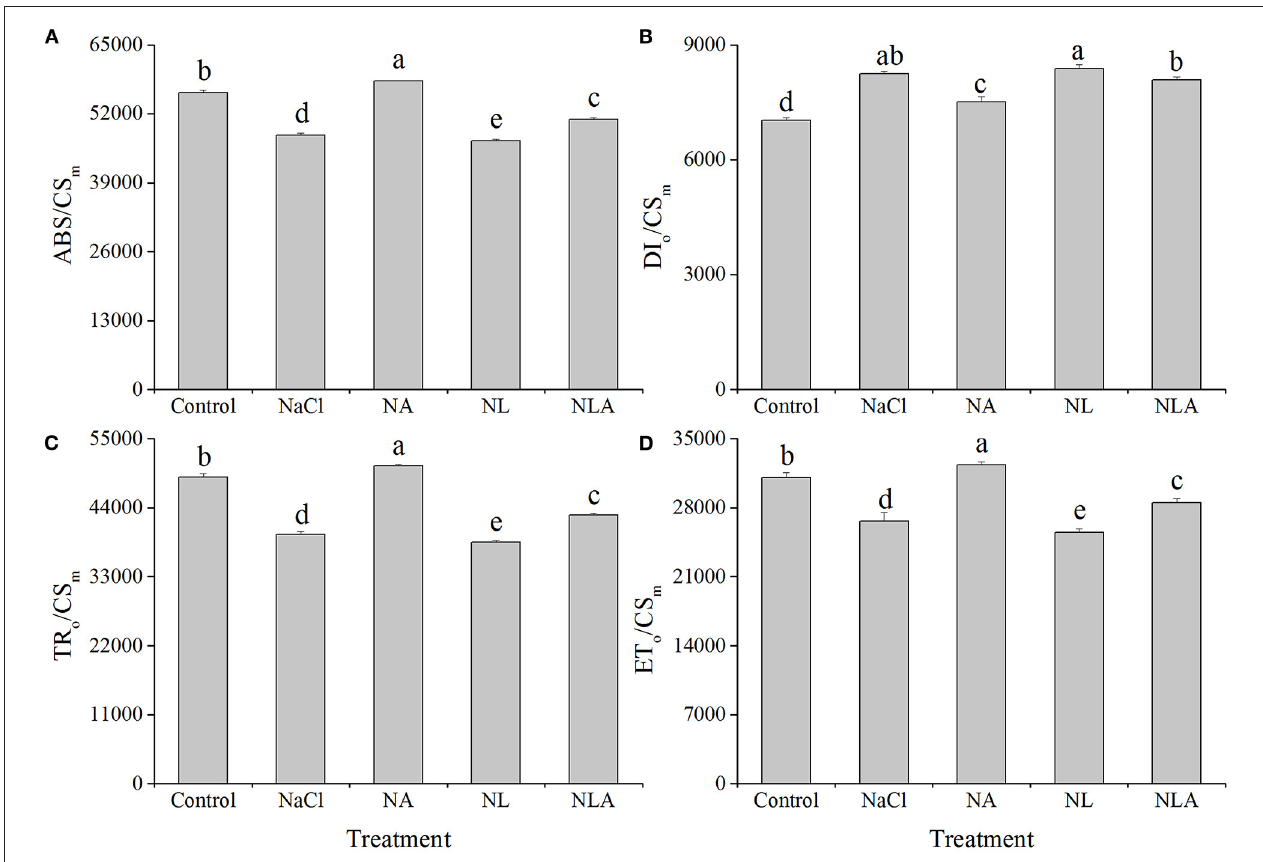
FIGURE 9 | Parameters of absorption flux per CS (at t = F m ) (ABS/CS m ) (A) , dissipated energy flux per CS (at t = F m ) (DI o /CS m ) (B) , trapped energy flux per CS (at t = F m ) (TR o /CS m ) (C) , and electron transport flux per CS (at t = F m ) (ET o /CS m ) (D) in leaves of salt-stressed tomato seedlings with or without exogenous reduced ascorbic acid (AsA) and lycorine (LYC) spraying. Values are means ± SD ( n = 3). Different letters (a, b, c, d, and e) indicate significant difference at P < 0.05 among treatments. Error bar is smaller than the line at the top of the graph. Control, no added NaCl, no sprayed AsA and LYC; NaCl, added 100 mmol/L NaCl; NA, added 100 mmol/L NaCl and sprayed 0.5 mmol/L AsA; NL, added 100 mmol/L NaCl and sprayed 0.25 mmol/L LYC; NLA, added 100 mmol/L NaCl and sprayed 0.25 mmol/L LYC and 0.5 mmol/L